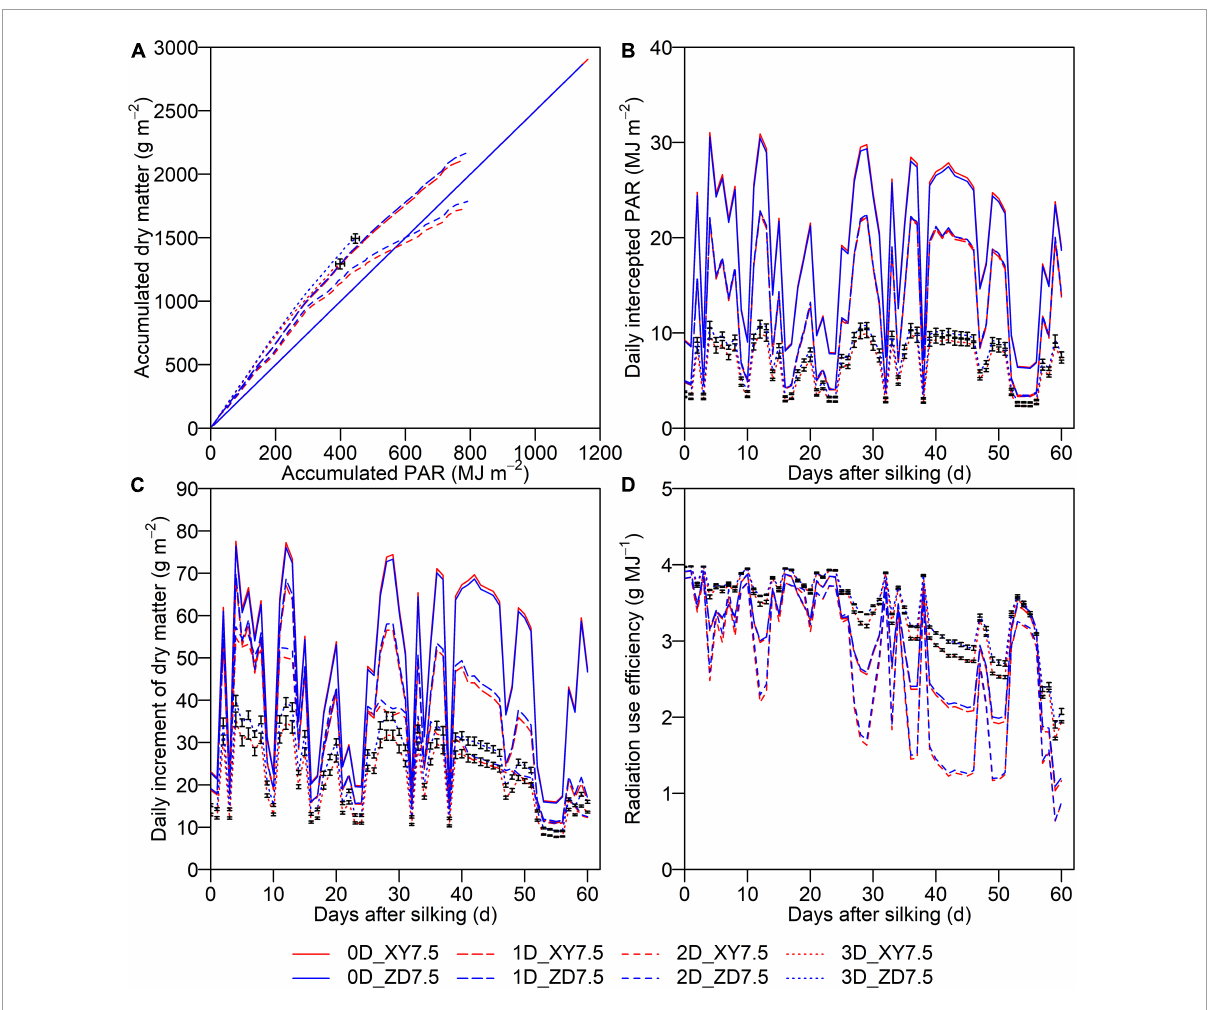
FIGURE6 Cumulative dry matter after silking as a function of accumulated PAR (A) and dynamics of daily intercepted PAR (B) , daily increment of dry matter (C) , and daily radiation use efficiency (D) during post-silking period. Solid lines denote the 0D model, longdash lines denote the 1D model, dashed lines denote the 2D model, and dotted lines denote the 3D model. Blue denotes ZD958 and red denotes XY335 at the density of 7.5 plants m - 2 . Error bars indicate the